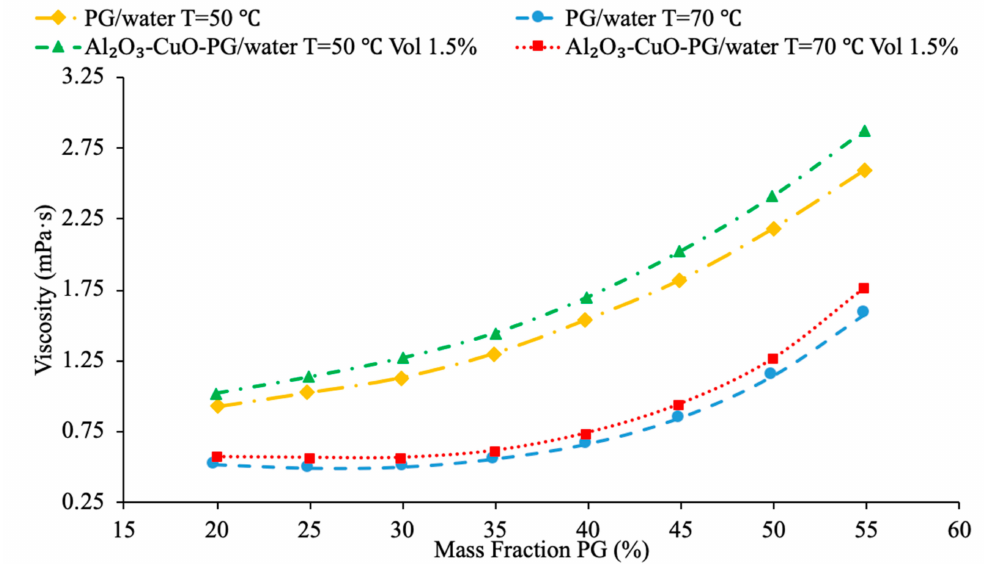
Figure 21. Viscosity of Al 2 O 3 /CuO nanofluid in base fluid of water and propylene glycol (PG) with changing mass fraction of PG [61].